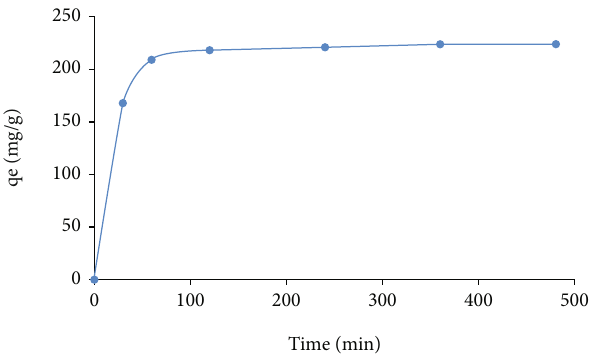
Figure 6: E ff ect of time on the adsorption of toluidine on polymeric hydrogel (adsorbent dosage 0.01g, dye solution 10mL, time 30 – 480min, pH = 11 , temperature 313 K).